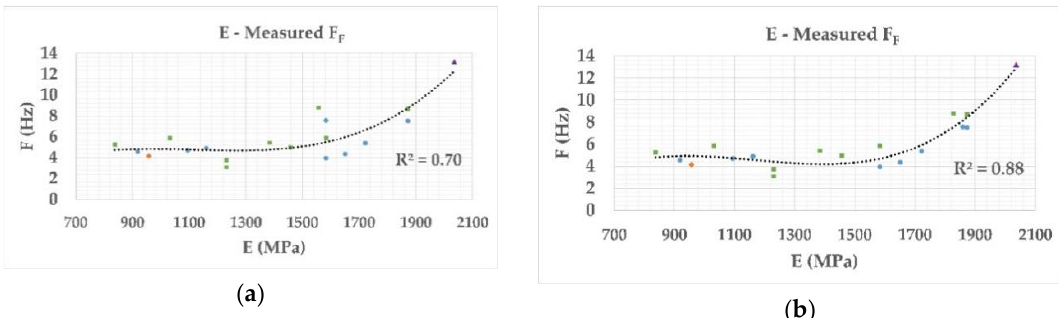
Figure 22. Comparison between the estimated elastic modulus (E) and the measured natural frequency (F). Green square: cube-shaped; blue circle: cylindrical shaped; orange diamond: Agicampe tower (cube-shaped + cylindrical); purple triangle: horseshoe-shaped. ( a ) Average E value directly based on masonry quality index (MQI). ( b ) E value adjusted according to masonry resistance analysis.